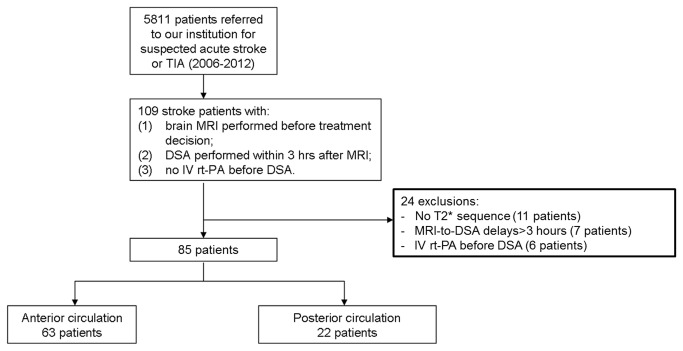
Flowchart of patients.